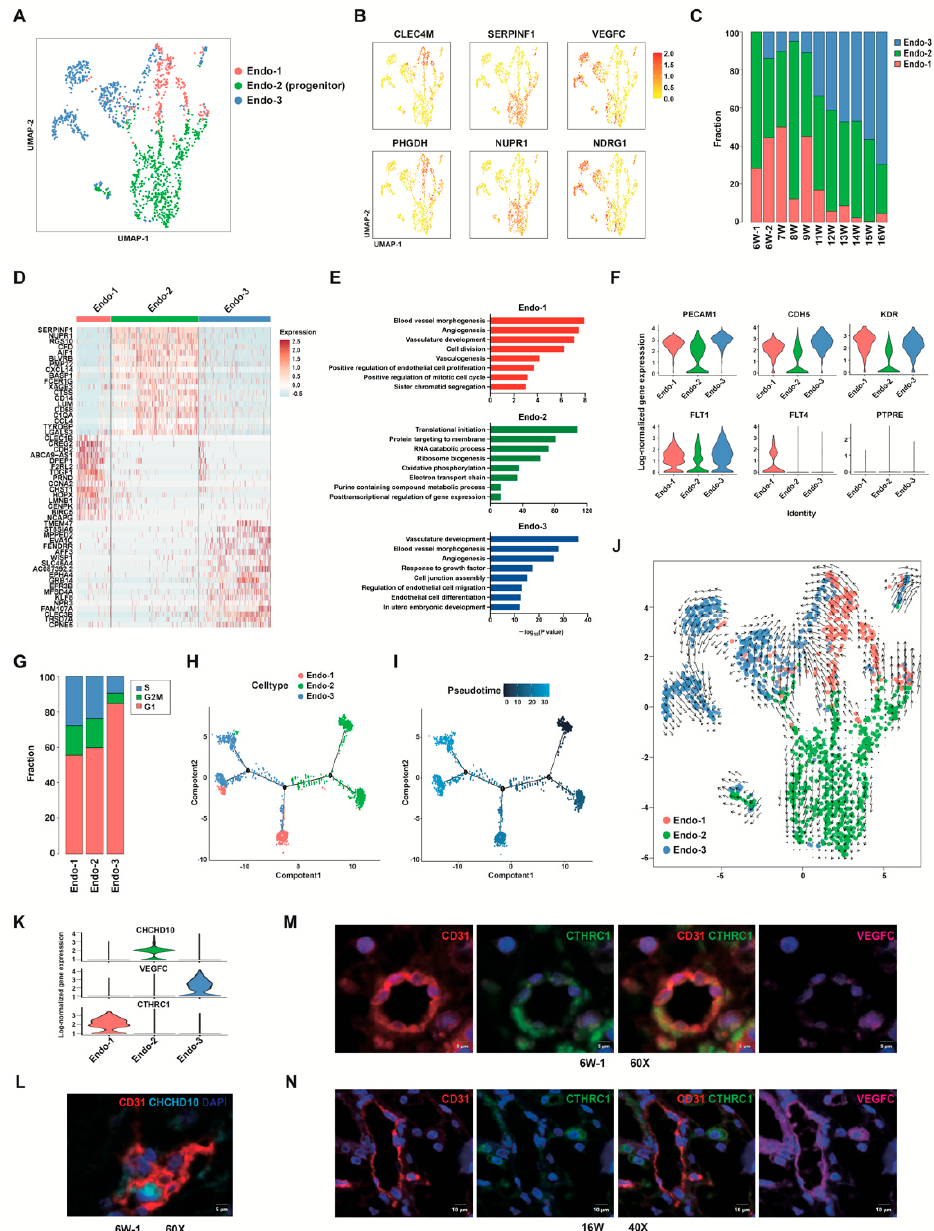
Figure 2. Single-cell RNA-seq analysis of placental endothelial cells from the first and second trimesters. ( A ) UMAP plot showing three different subtypes of human placental endothelial cells. ( B ) UMAP plots of the expression distribution for selected cluster-specific genes. ( C ) The proportions of three EC clusters at each developmental timepoint. ( D ) Heatmap of top 20 DEGs in three EC clusters. ( E ) Representative GO analysis terms of DEGs in Endo-1 (red), Endo-2 (green) and Endo-3 (blue) clusters. ( F ) Violin plots showing the expression levels of endothelial markers PECAM1 and CDH5 , VEGFR coding genes FLT1 , FLT4 , and KDR , hematopoietic marker PTPRE in each EC clusters. ( G ) Cell cycle analysis of three EC clusters. ( H , I ) Pseudotime analysis of placental endothelial cells, cells on the tree are colored by cluster ( H ) or pseudotime ( I ). ( J ) Projection of non-linear RNA velocity fields onto the UMAP space in ( A ). ( K ) Violin plot displaying selected cluster-specific genes. ( L ) Immunofluorescence staining of human first-trimester placental villi using the CD31 and CHCHD10 antibodies. DAPI staining shows the nuclei. Scale bar, 5 μ m. ( M ) Immunofluorescence staining of human first trimester placental villi using CD31, VEGFC, CTHRC1 antibodies. Scale bar, 5 μ m. ( N ) Immunofluorescence staining of human second trimester placental villi using CD31, VEGFC, CTHRC1 antibodies. Scale bar, 10 μ m. DEGs, differentially expressed genes.